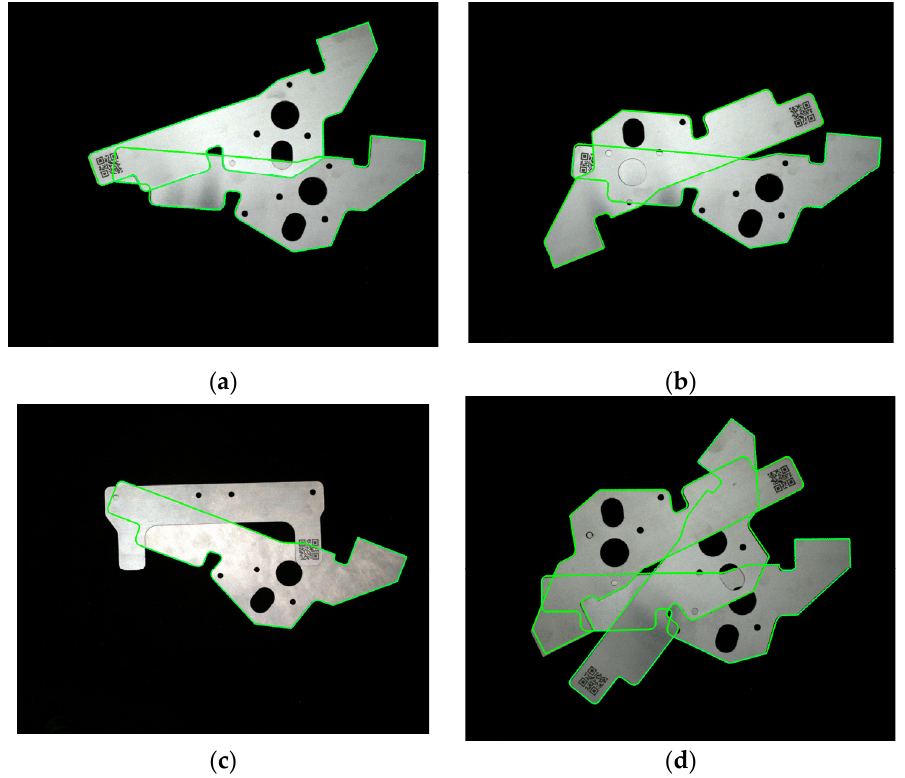
Figure 21. Results of stacked part positioning in different situations: ( a ) approximately 20% of the part is occluded, ( b ) approximately 40% of the part is occluded, ( c ) the part is occluded by parts that are not the same shape, and ( d ) multiple parts are stacked together.